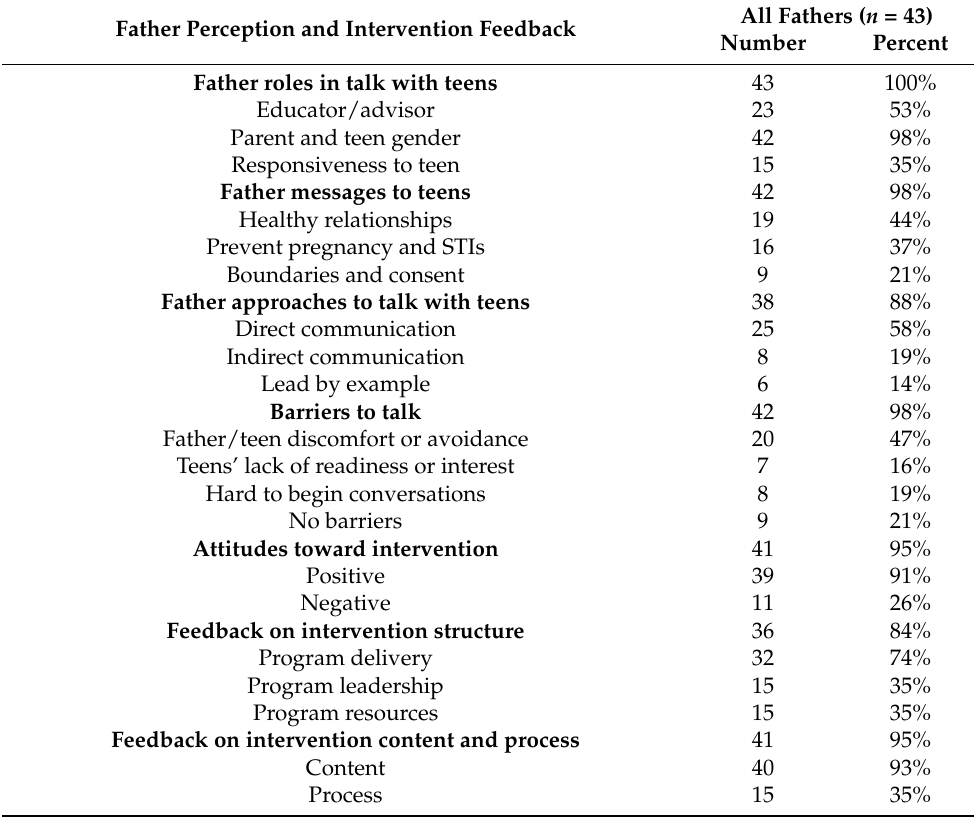
Table 3. Father perception and intervention feedback themes and